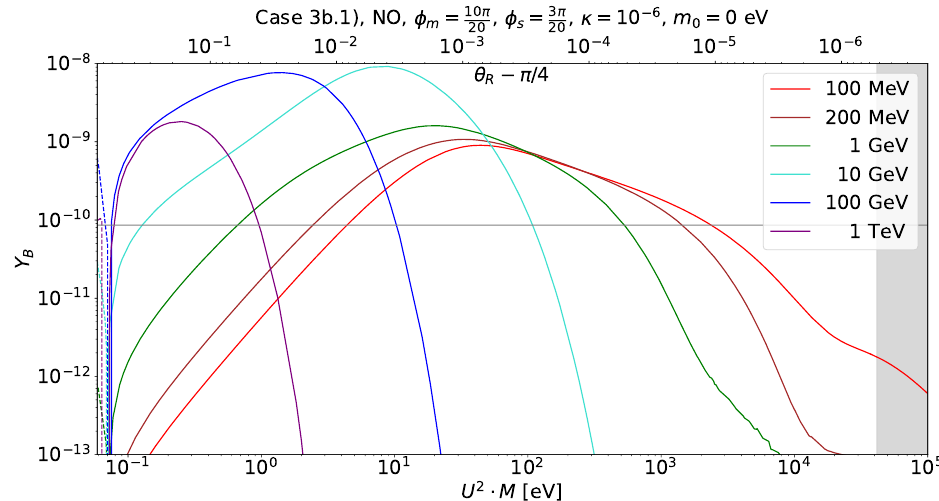
Figure 41 . Case 3 b.1) Y B as function of U 2 · M for different values of the Majorana mass M . The splitting κ is set to 10 − 6 . Light neutrino masses follow strong NO. The group theory parameters n , m and s are fixed to n = 20 , m = 10 and s = 3 . Both negative (dashed lines) as well as positive (continuous lines) values of the BAU are represented. The grey line indicates the observed value of the BAU, Y 8 . 6 · 10 − 11 . The grey shaded area represents the region in which a criterion similar B ≈ to the one in eq. (3.69) is not